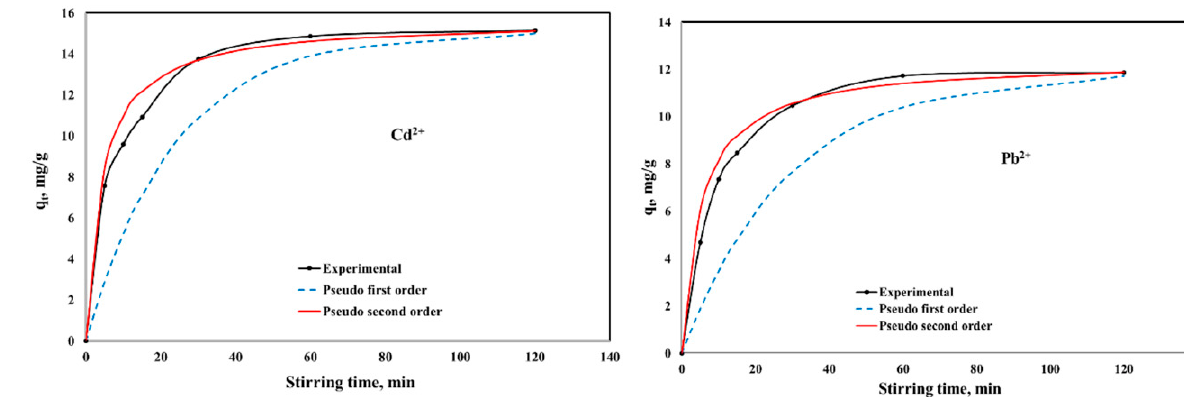
Figure 5. Kinetics of Cd 2+ and Pb 2+ adsorption onto CaCEPPA.